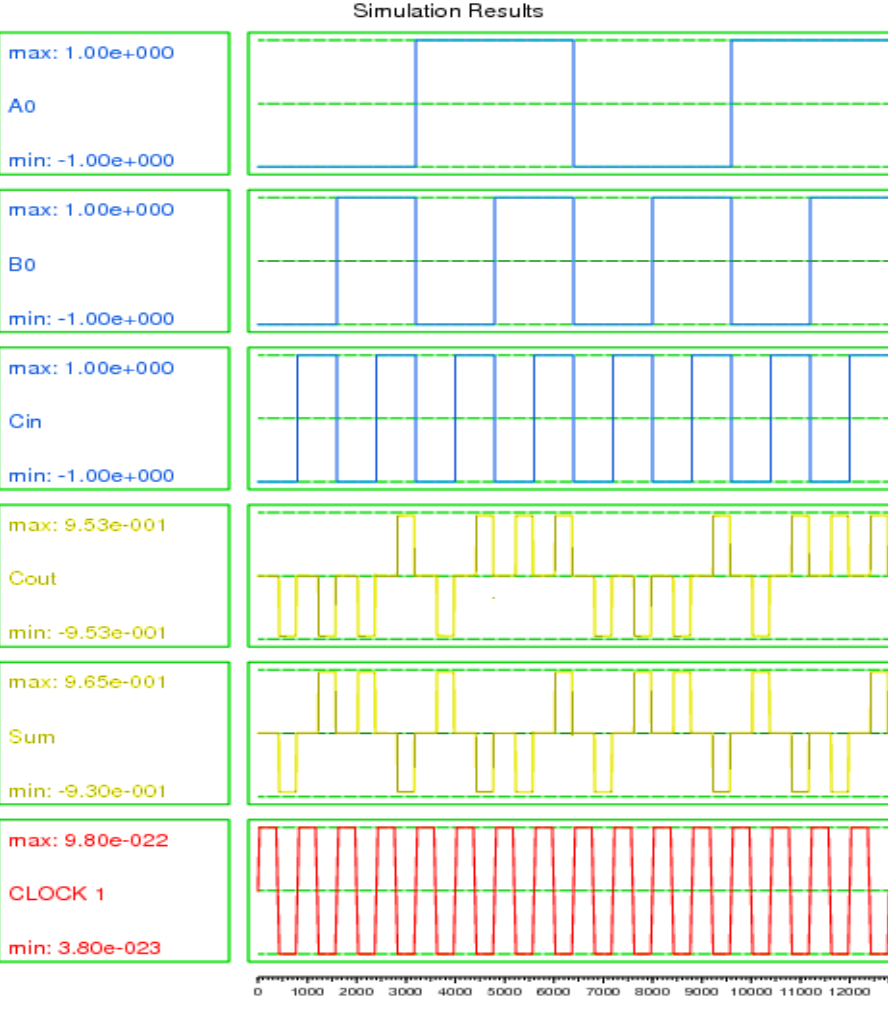
Figure 6. Simulation results of the proposed ( a , b ) FA circuits.